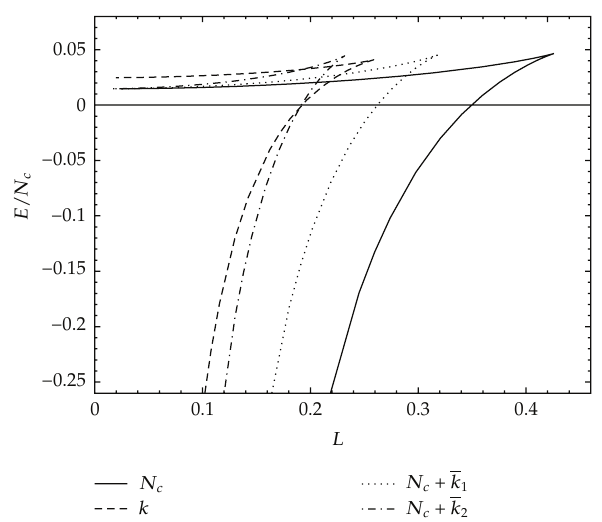
Figure 2: Comparison of the potential per N c between N c -baryon, k -baryon, and (cid:3) N c (cid:9) k (cid:4) -baryon for k/N c (cid:8) 0 . 8 , k 1 /N c (cid:8) 2 / 3, and k 2 /N c (cid:8) 2 at temperature T (cid:8) 0 .